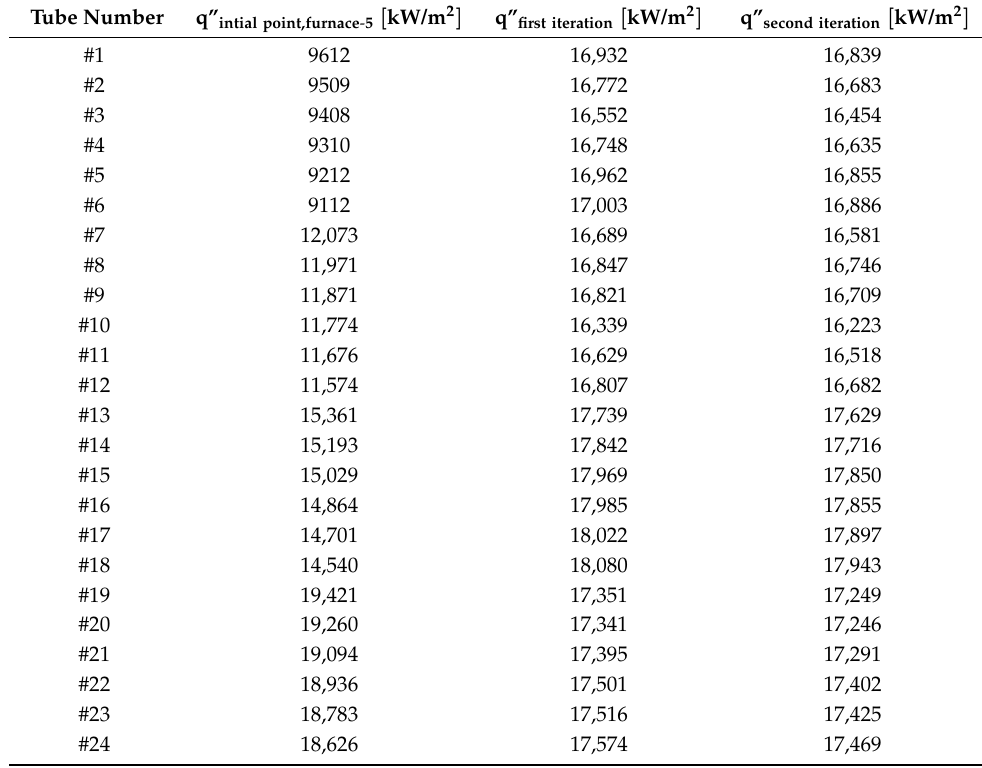
Table 14. Comparison among three iterations in coupling